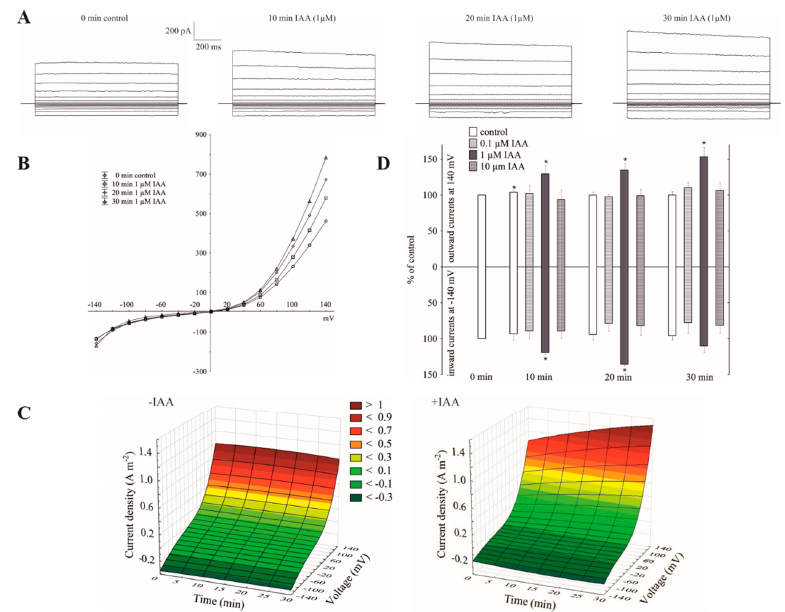
Figure 1. Effect of cytosolic auxin (indole-3-acetic acid, IAA) on the fast-activating currents in red beet taproot vacuoles. ( A ), An example of a whole-vacuole fast-activating vacuolar (FV) current recording in the control bath solution and in the presence of 1 µM IAA. The control at “0 time” (0 min control) means the whole-vacuole FV current that was recorded in a symmetrical 100 mM KCl immediately after gaining access to the whole vacuole; however, the current in the absence and presence of IAA was recorded 5, 10, 15, 20, 25 and 30 min later. For clarity, only the FV currents in the control (0 min control) and the presence of IAA after 10, 20 and 30 min are shown. ( B ), The instantaneous vacuolar currents shown as a function of voltage (the data are from the same experiment as shown in A). ( C ), The current–voltage relationships in the absence ( − IAA) and presence (+IAA) of 1 µM IAA shown as a function of time. The means of at least seven different vacuoles are shown. ( D ), The dependence of the whole-vacuole FV currents (recorded at − 140 and +140 mV) on the cytosolic IAA concentration and time. The data are expressed as a % of the control (0 min control). The means ± SE of at least seven different vacuoles are shown. The normal distribution was evaluated by the Shapiro–Wilk test ( p > 0.05). The statistical differences between control at 0 min and other variants at the same voltage were analyzed using a paired t -test ( p < 0.05). Asterisk (*) indicates significant difference.